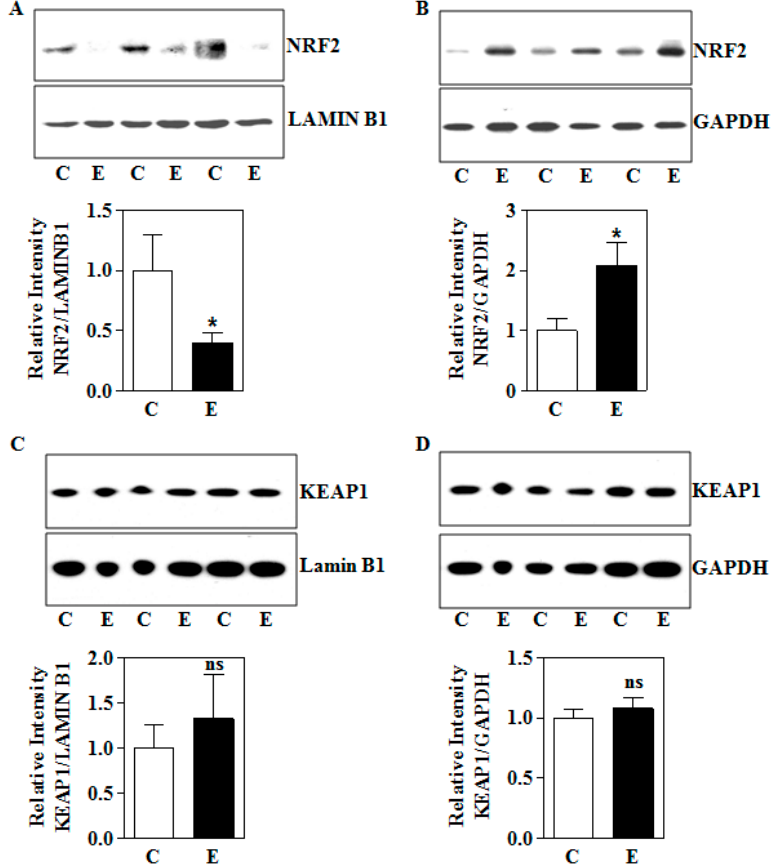
Figure 3. Effect of intrauterine alcohol exposure on NRF2 and KEAP1 protein expression. ( A ) A representative immunoblot image detecting placental NRF2 and LAMIN B1 protein expression in nuclear fraction (upper panel) and its quantification (bottom panel) from air (C) and IEV (E) exposed rats (hours) (total n = 12; n = 4 each from 3 different litters); ( B ) immunodetection of placental NRF2 and GAPDH protein in the cytosol of air (C) and IEV (E) exposed pregnant rats measured by Western blotting (upper panel) and the corresponding quantification of NRF2 protein levels normalized to the reference protein, GAPDH (bottom panel) (total n = 12; n = 4 each from 3 different litters); ( C ) Western blot image of KEAP1 and LAMIN B1 protein in placenta obtained from air (C) or vapor based ethanol (IEV)-exposed pregnant dams (upper panel) and the image densities of KEAP1 relative to LAMIN B1 (bottom panel) (total n = 12; n =4 each from 3 different litters); ( D ) representative immunoblots demonstrating the expression of KEAP1 protein, with GAPDH as a loading control in placenta of control and intrauterine alcohol-exposed pregnant rats (upper panel) and the quantification of immunoblots of KEAP1 normalized to GAPDH (bottom panel). Values represent the mean ± SEM. * p < 0.05 was considered significant vs ethanol.